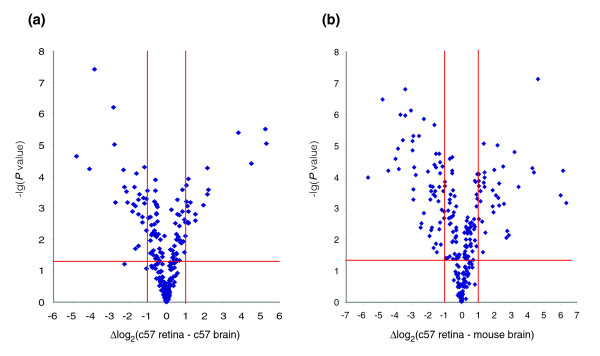
Volcano plots of miR expression in wild-type retina versus brain and mouse platform. Plots represent comparative miR expression profiles of (a) c57 retina versus c57 brain and (b) c57 retina versus mouse platform using Exiqon miR microarrays. X-axis indicate difference in expression level on a log2 scale, whereas the y-axis represents corresponding P values (Student's t-test) on a negative log scale; more lateral and higher points mean more extensive and statistically significant differences, respectively. Red lines indicate differences of ± 1, and significance level of P = 0.05. miR, microRNA.